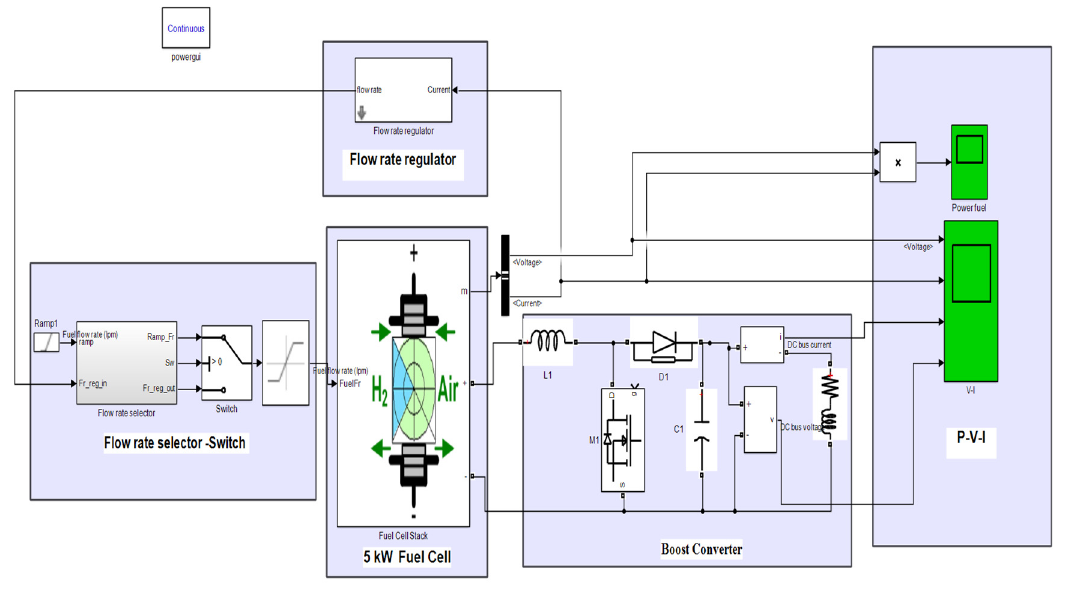
Figure 6. Study system without controller. Table 3. Information of the studied system.